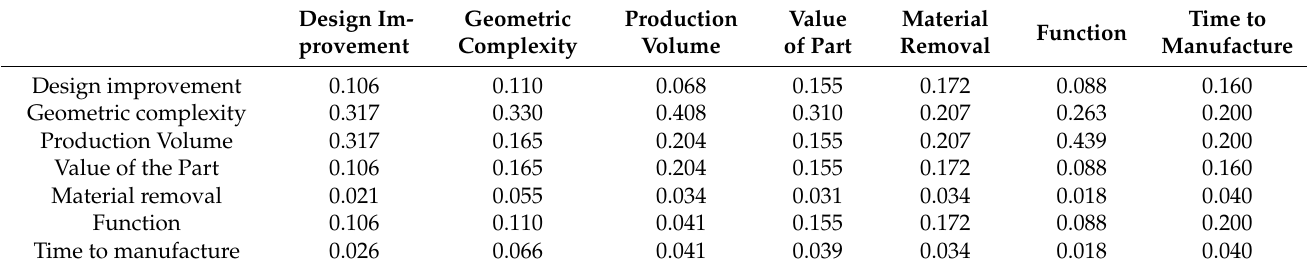
Table 7. Normalised